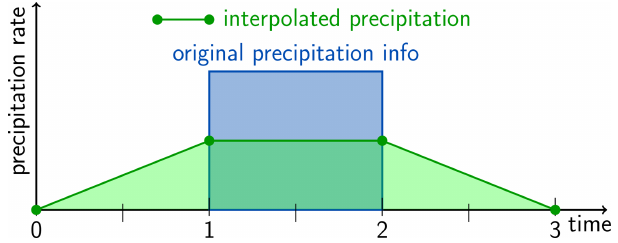
Figure 5. Example of disaggregation scheme as implemented in older versions of flex_extract for an isolated precipitation event last- ing one time interval (thick blue line). The amount of original pre- cipitation after de-accumulation is given by the blue-shaded area. The green circles represent the discrete grid points after disaggre- gation. FLEXPART interpolates linearly between them as indicated by the green line and the green-shaded area. Note that supporting points for the interpolation are shifted by half a time interval com- pared to the other meteorological fields. From Hittmeir et al. (2018).